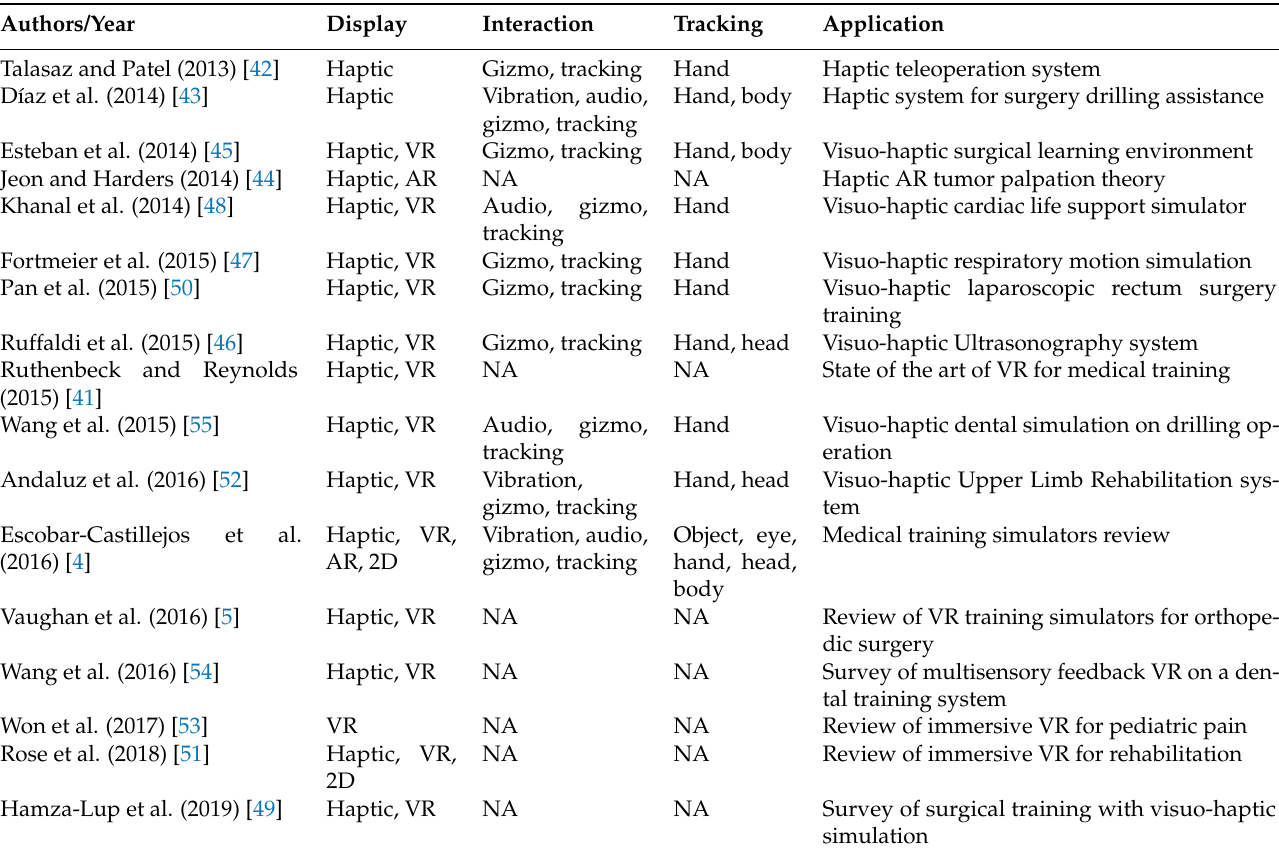
Table 3. Data table of the Medicine